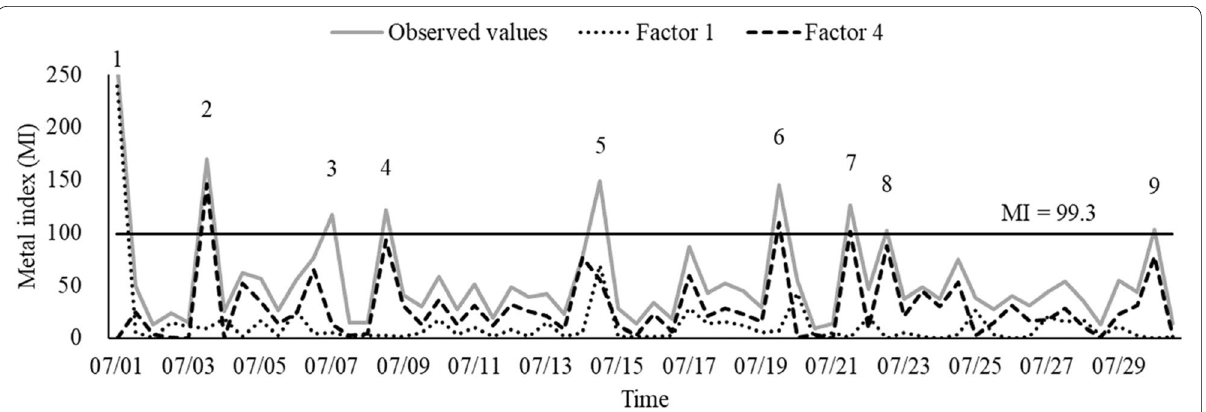
Fig. 3 Measured MI and contributions of Factors 1 and 4 estimated using PMF. The event number is displayed above the peak